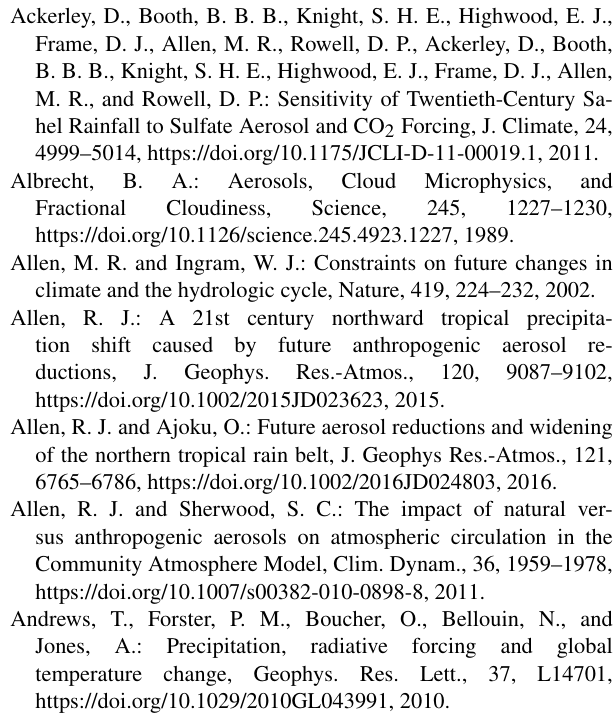
figshare.com/articles/ERF/5732397. GISS-E2 data are available at https://figshare.com/articles/GISS_data/5738565/1, and GFDL- CM3 is available at https://figshare.com/articles/GFDL_precip_ data/5738562, (Westervelt, 2018). Model data are also available on the high-performance computing clusters for each of the modeling centers. Contact the corresponding author for any additional data